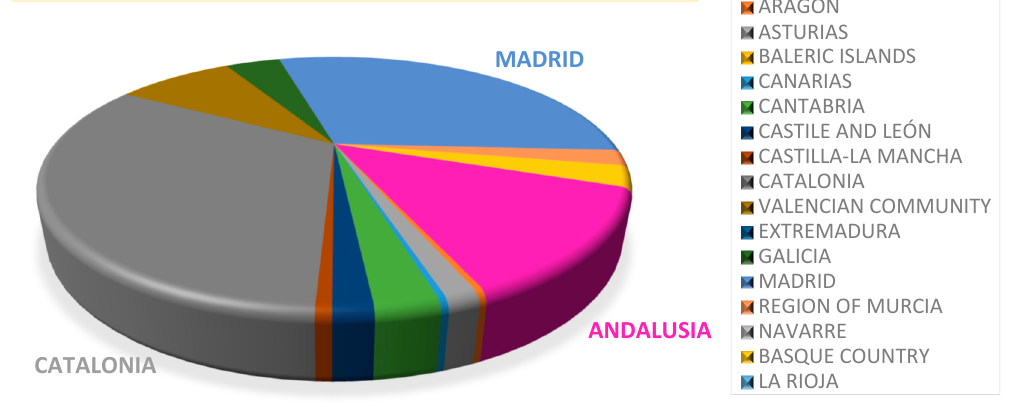
Figure 2. CSUR distribution. Most of these Reference Centres , Services and Units (CSUR) are in the regions of Catalonia, Madrid, and Andalusia. Source: Listado CSUR,